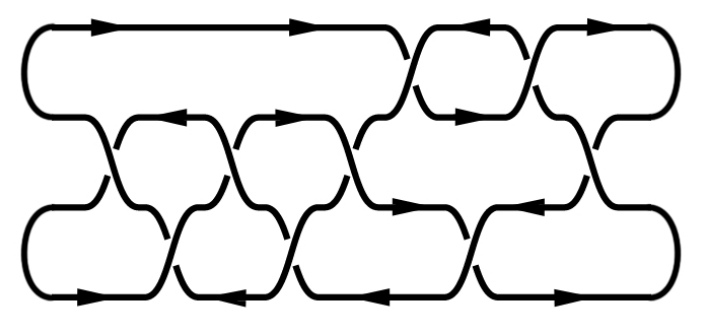
Figure 2. Plat representation of the knot 9 14